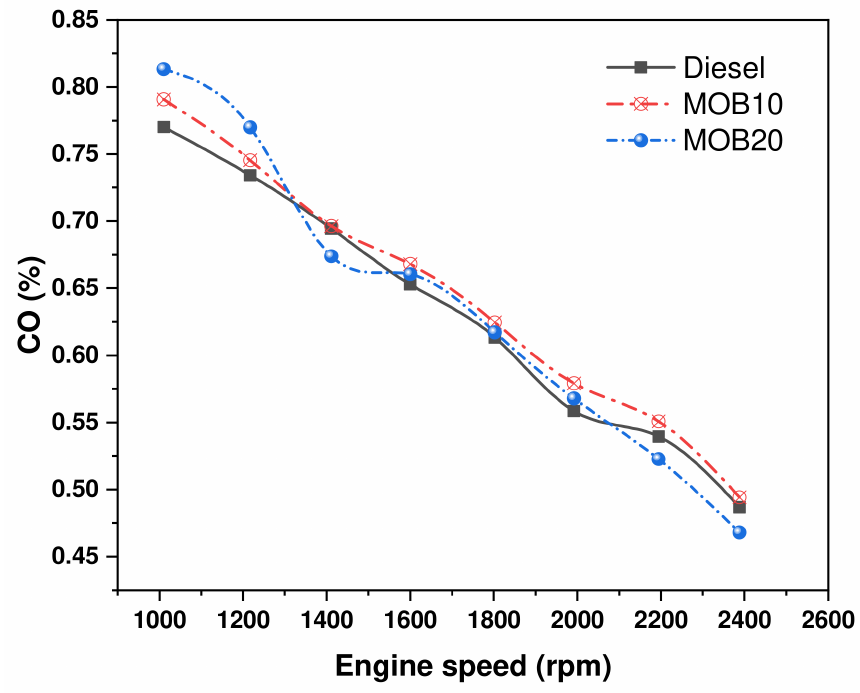
Figure 7. Carbon monoxide emissions of Moringa oleifera biodiesel blends and diesel at various engine